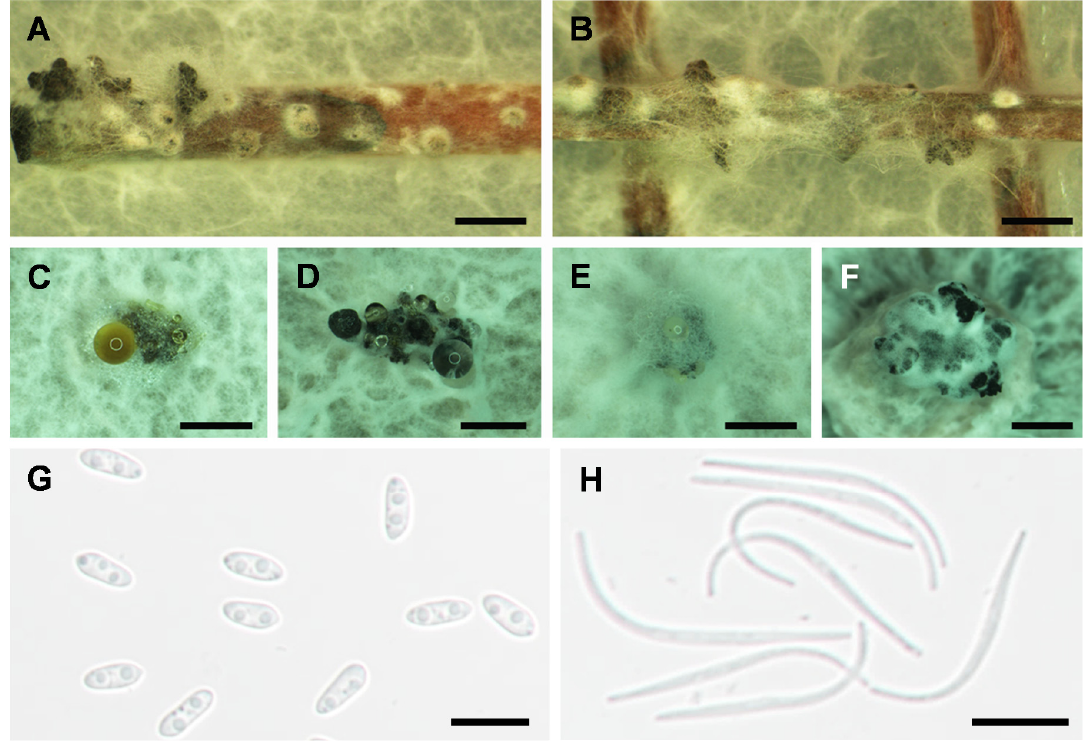
Figure 2. Asexual reproduction of Diaporthe passifloricola (NFIF-3-21). ( A , B) , conidiomata on PNA after 30 days incubation, ( C – F ), conidiomata on PDA after 30 days incubation, ( G ), alpha ( α ) conidia, ( H ), beta ( β ) conidia. Scale bars: A – B , 500 µm; C – F , 200 µm; G – H , 10 µm.